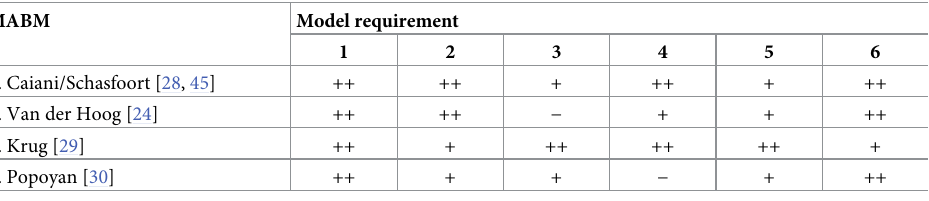
Table 5. Related literature in comparison to